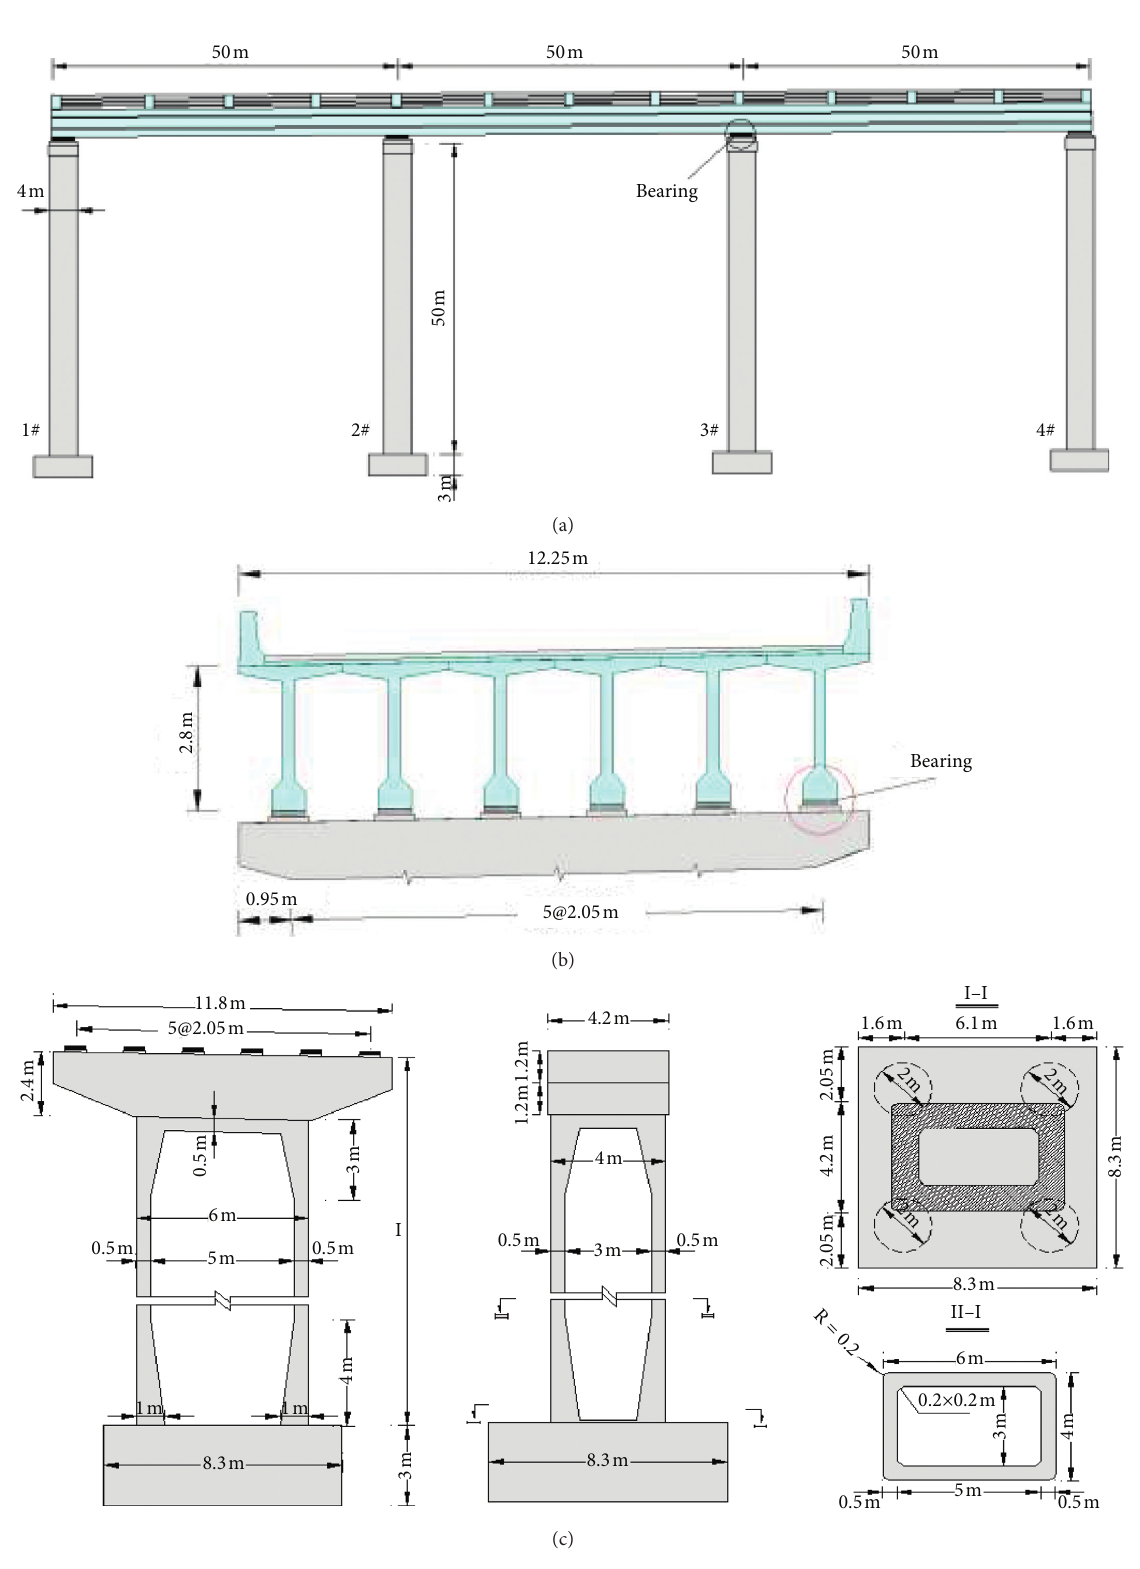
Figure 3: Simplified bridge geometry: (a) longitudinal view of the bridge; (b) transverse view of the superstructure; (c) details of the